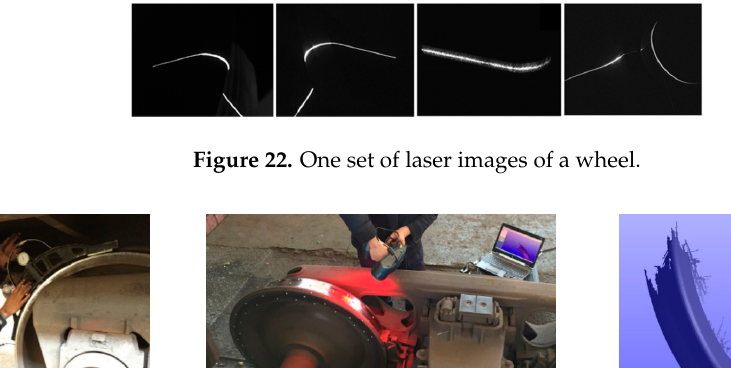
Figure 23. The manual measurement. ( a ) Using the diameter caliper; ( b ) using the 3D scanner; ( c ) the 3D shape result of the scanner.